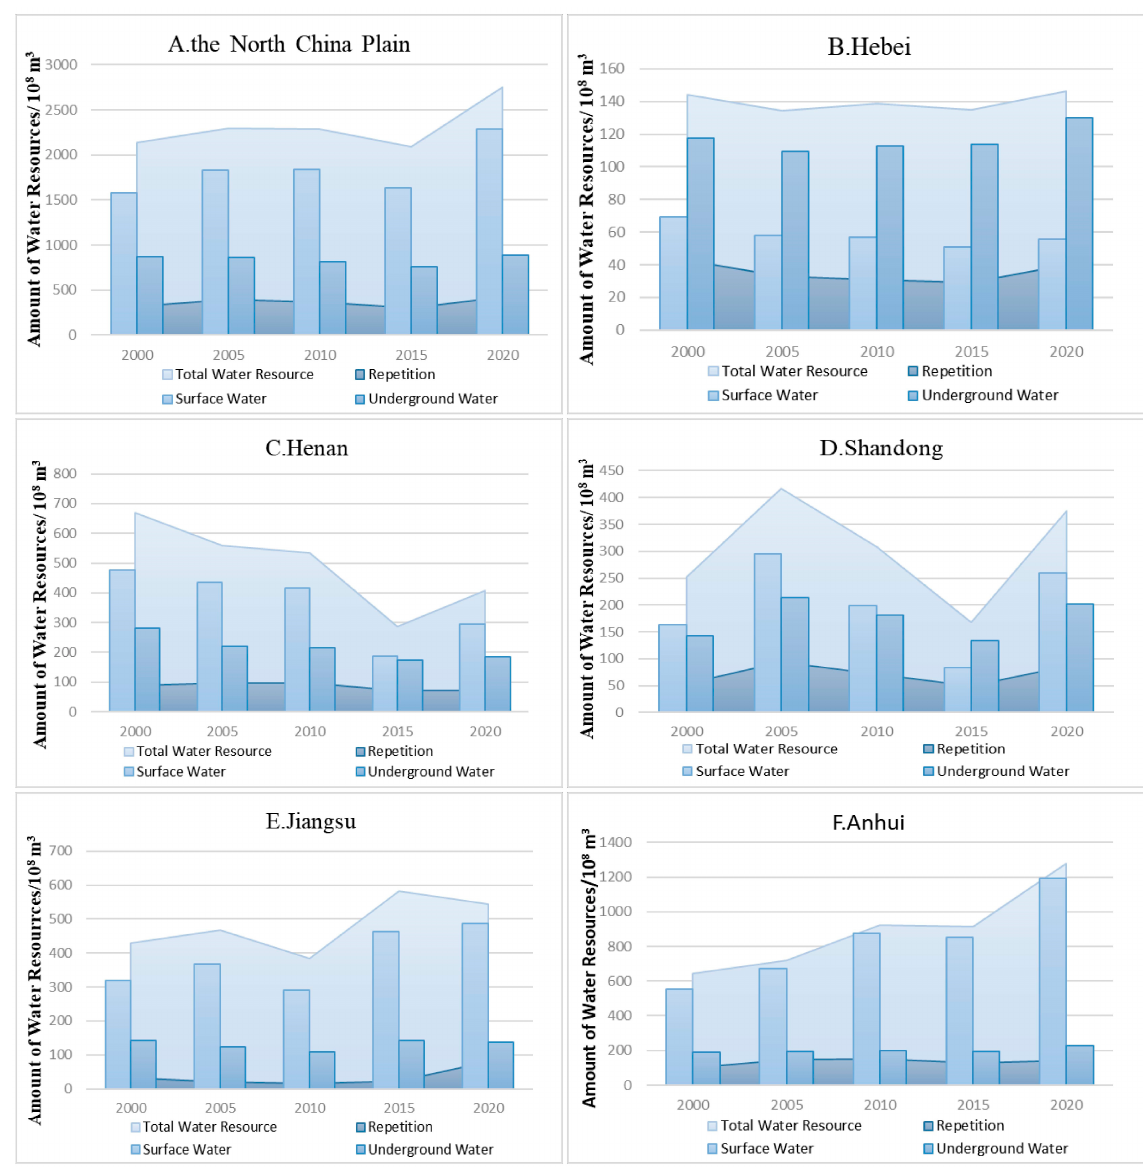
Figure 2. The changes in total water resources and their composition from 2000 to 2020 in the main grain-producing area of North China ( A ), Hebei ( B ), Henan ( C ), Shandong ( D ), Jiangsu ( E ), and Anhui ( F ) province.